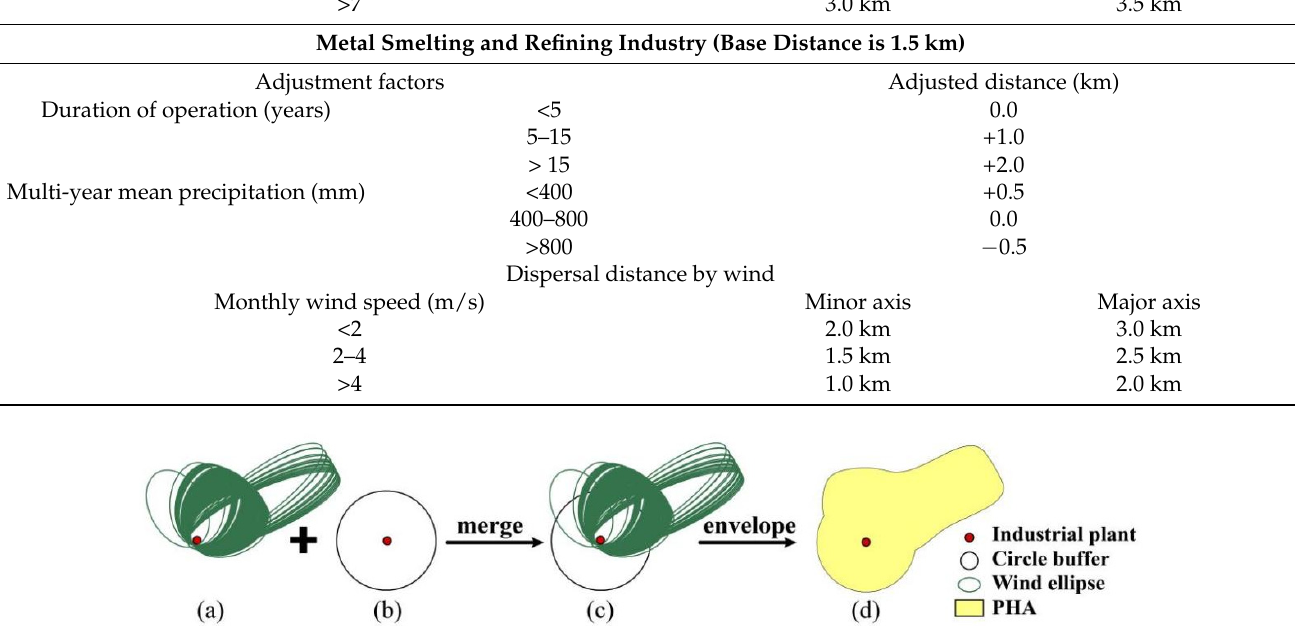
Figure 3. Conceptual model of the potentially hazardous area simulation. ( a ) Ellipses are generated according to monthly wind conditions. ( b ) Circle buffer of a given industrial plant. ( c ) The circle buffer and the ellipses are merged into a new feature. ( d ) The potentially hazardous area (PHA) is generated by enveloping the merged feature.